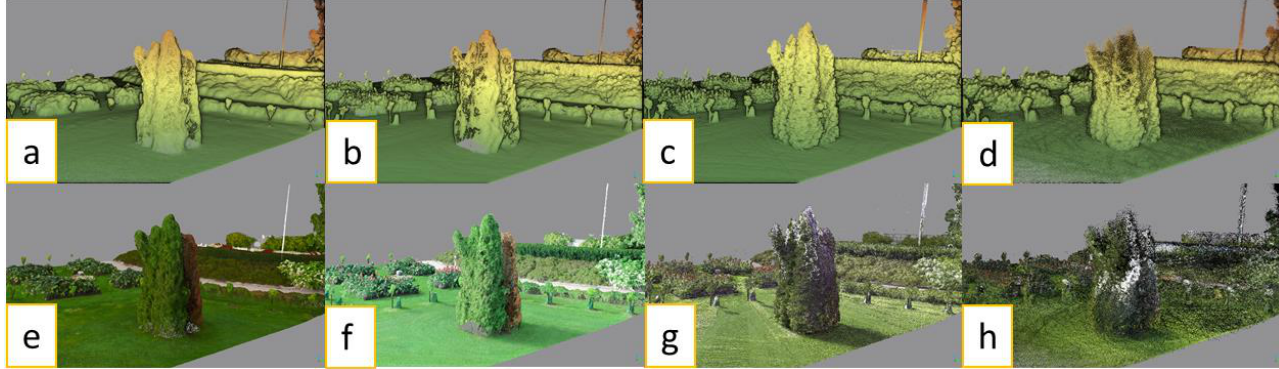
Figure 6. Comparisons of point clouds for large trees. In the top row, the point clouds are colored with the height ramp, and in the bottom row with RGB colorization.